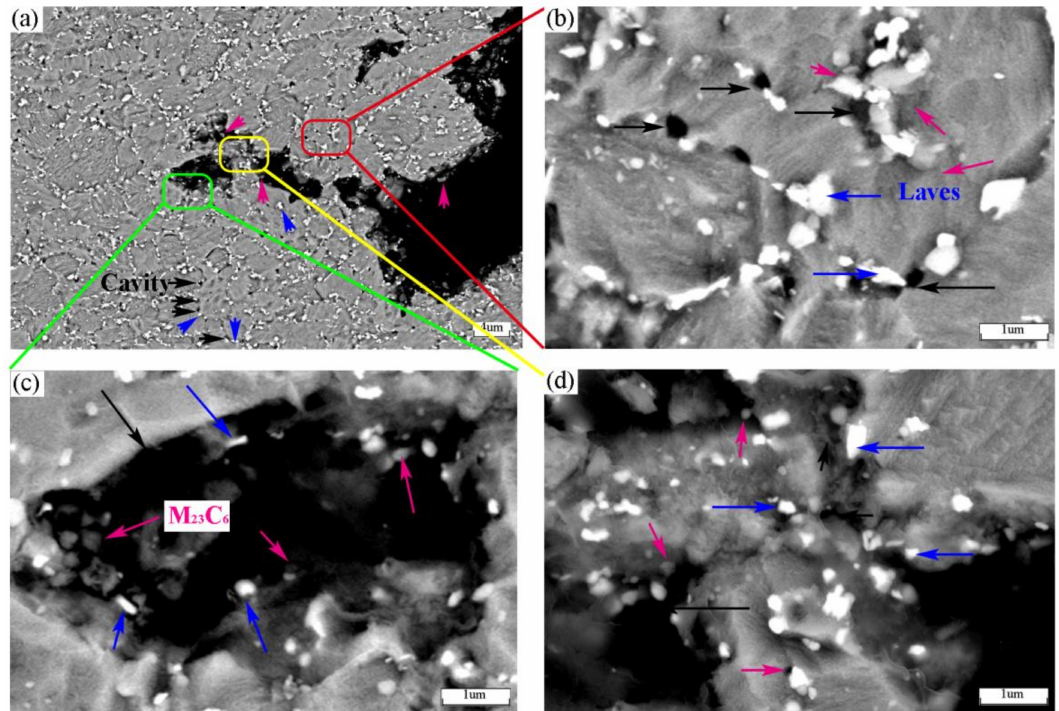
Figure 8. Precipitated phases near the 100 MPa fracture: ( a ) BSE pictures with lower magnification; ( b ) BSE pictures with smaller cavities; ( c ) BSE picture with bigger cavity; ( d ) Cavities in the trigeminal grain